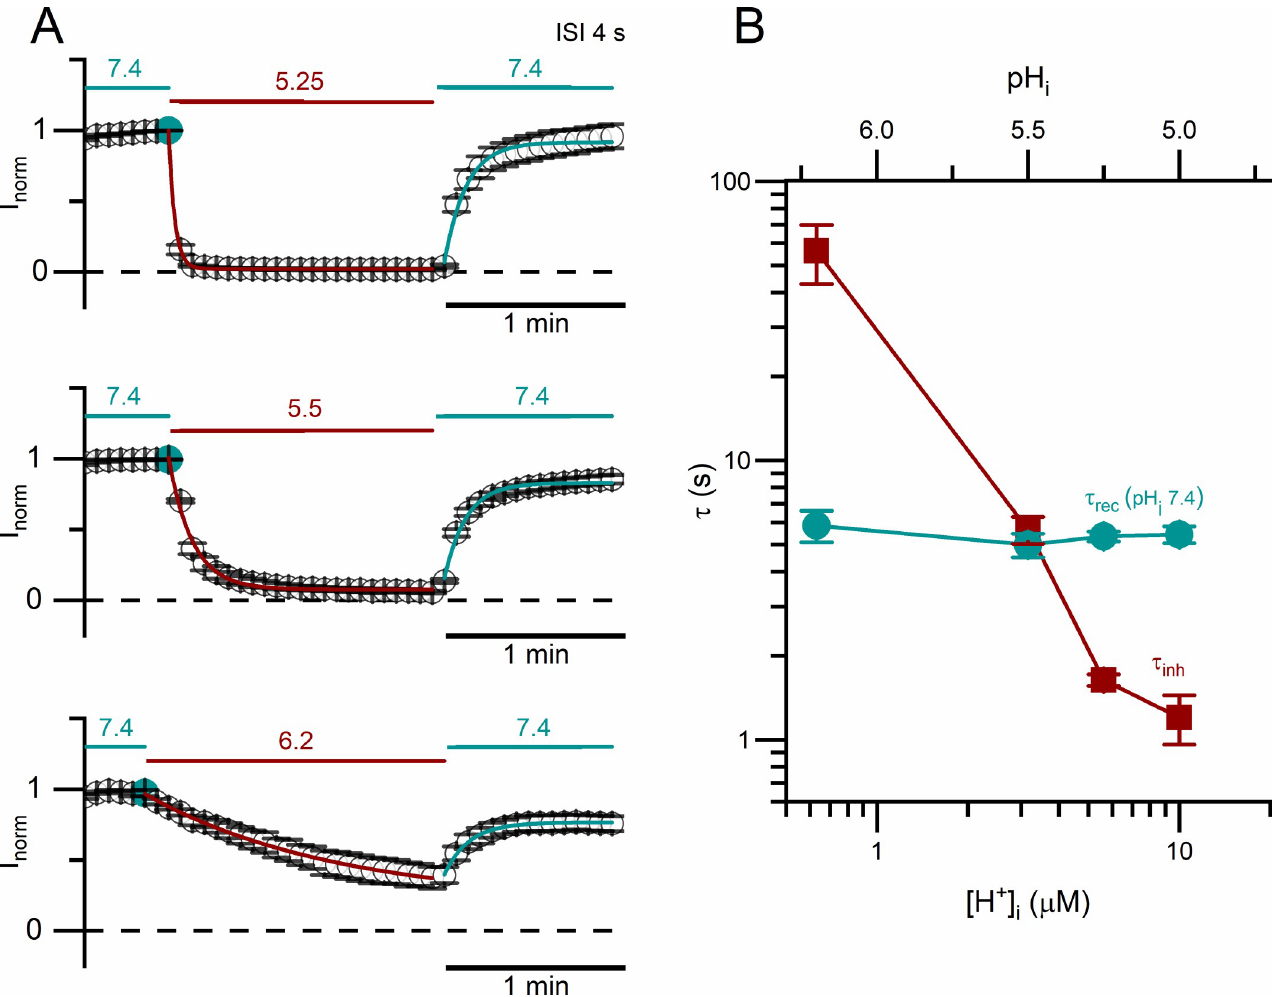
Fig 4. Kinetics of the current inhibition and recovery of WT CLC-0 upon switching pH i . Voltage protocol was as that shown in Fig 3A. All currents measured at +60 mV were normalized to that obtained right before the application of low pH i solutions. (A) Inhibition of WT CLC-0 currents by various low pH i solutions. ISI = 4 s. The numbers above the horizontal lines (teal and red colors) indicate the values of pH i . (B) Time constants of the inhibition (red squares) plotted against the values of pH i (and thus [H + ] i ). Time constants of current recovery (at pH i = 7.4) are also plotted (sea green circles). Results were obtained from recordings like those shown in A (n = 3–6).